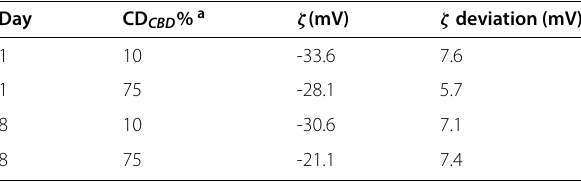
Table 1 ζ potential values of CD CBD nanoemulsions with varying lipid phase compositions